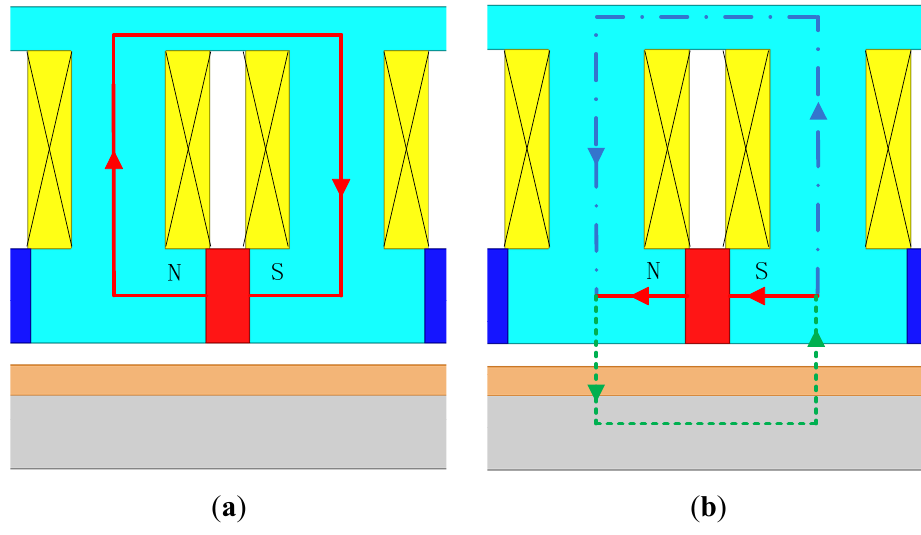
Figure 2. Flux flow: ( a ) excitation windings without excitation current and ( b ) excitation windings with excitation